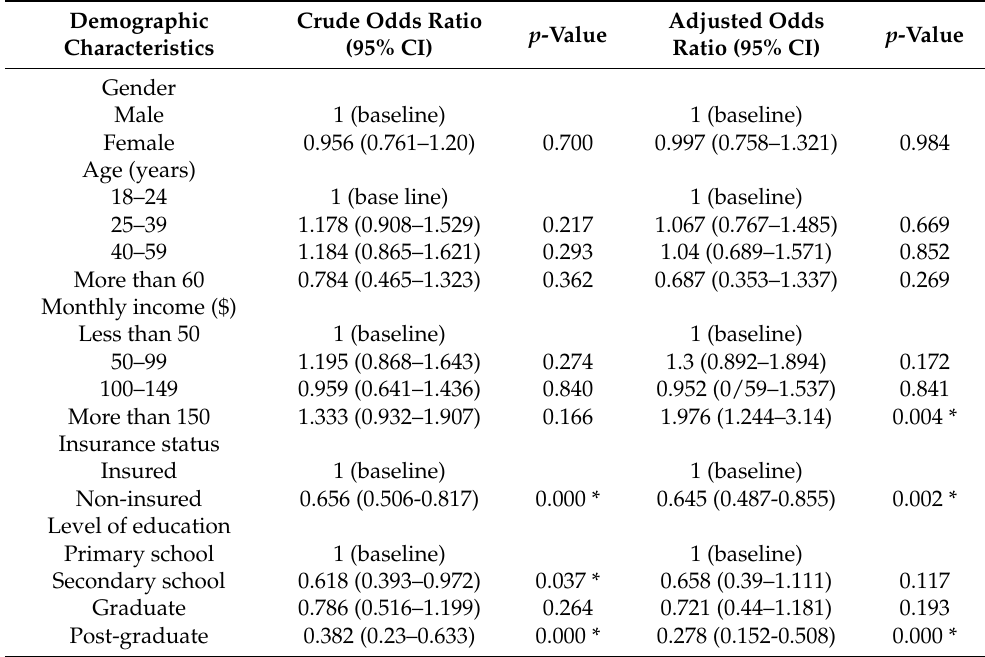
Table 4. Bivariate and multiple logistic regression of the demographic factors of SMA.